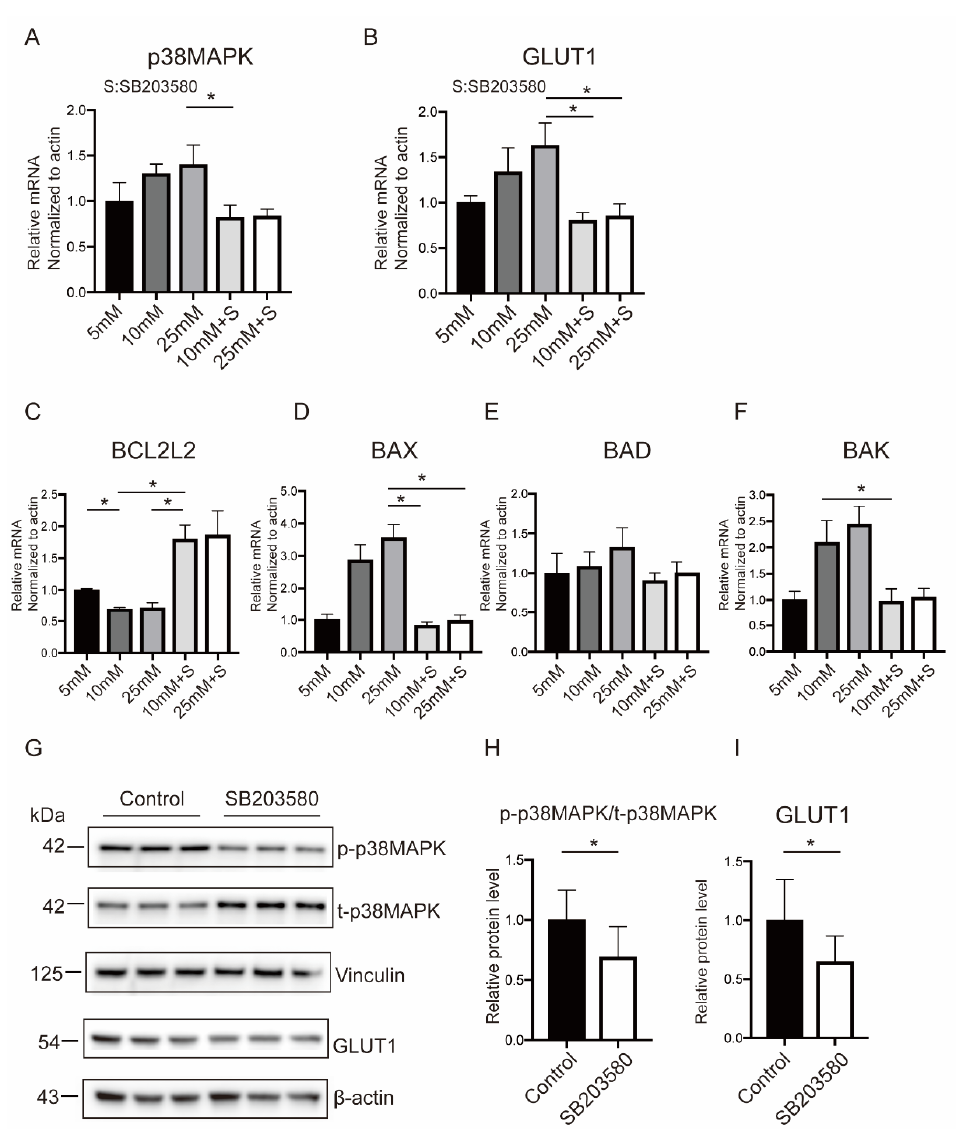
Figure 5. p38MAPK inhibition is associated with decreased GLUT1 and alleviated OS responses. ( A – F ) Cellular mRNA levels of p38MAPK ( A ), GLUT1 (B), and apoptotic molecules ( C – F ) in BeWo cells handled with the p38MAPK antagonist. ( G – I ) Cellular protein levels of p38MAPK and GLUT1 by adding the p38MAPK antagonist. Actin and Vinculin served as the internal controls. Data are the mean ± SEM. * p < 0.05 by a one-way ANOVA test, followed by a post hoc test. S: SB203580.